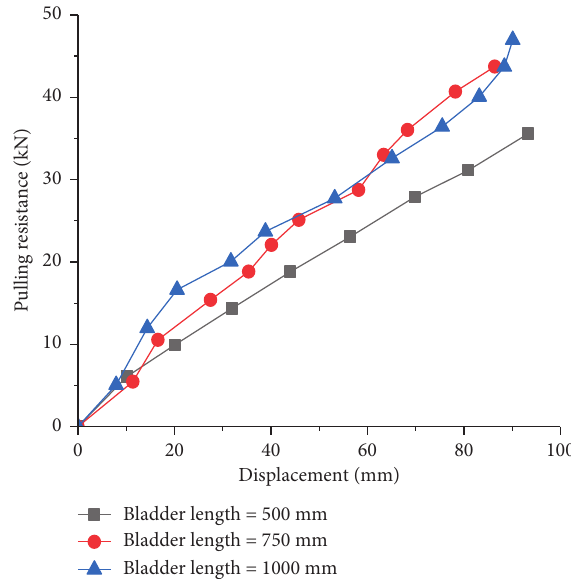
Figure 6: The pulling force vs. displacement relationship under different bladder length conditions.